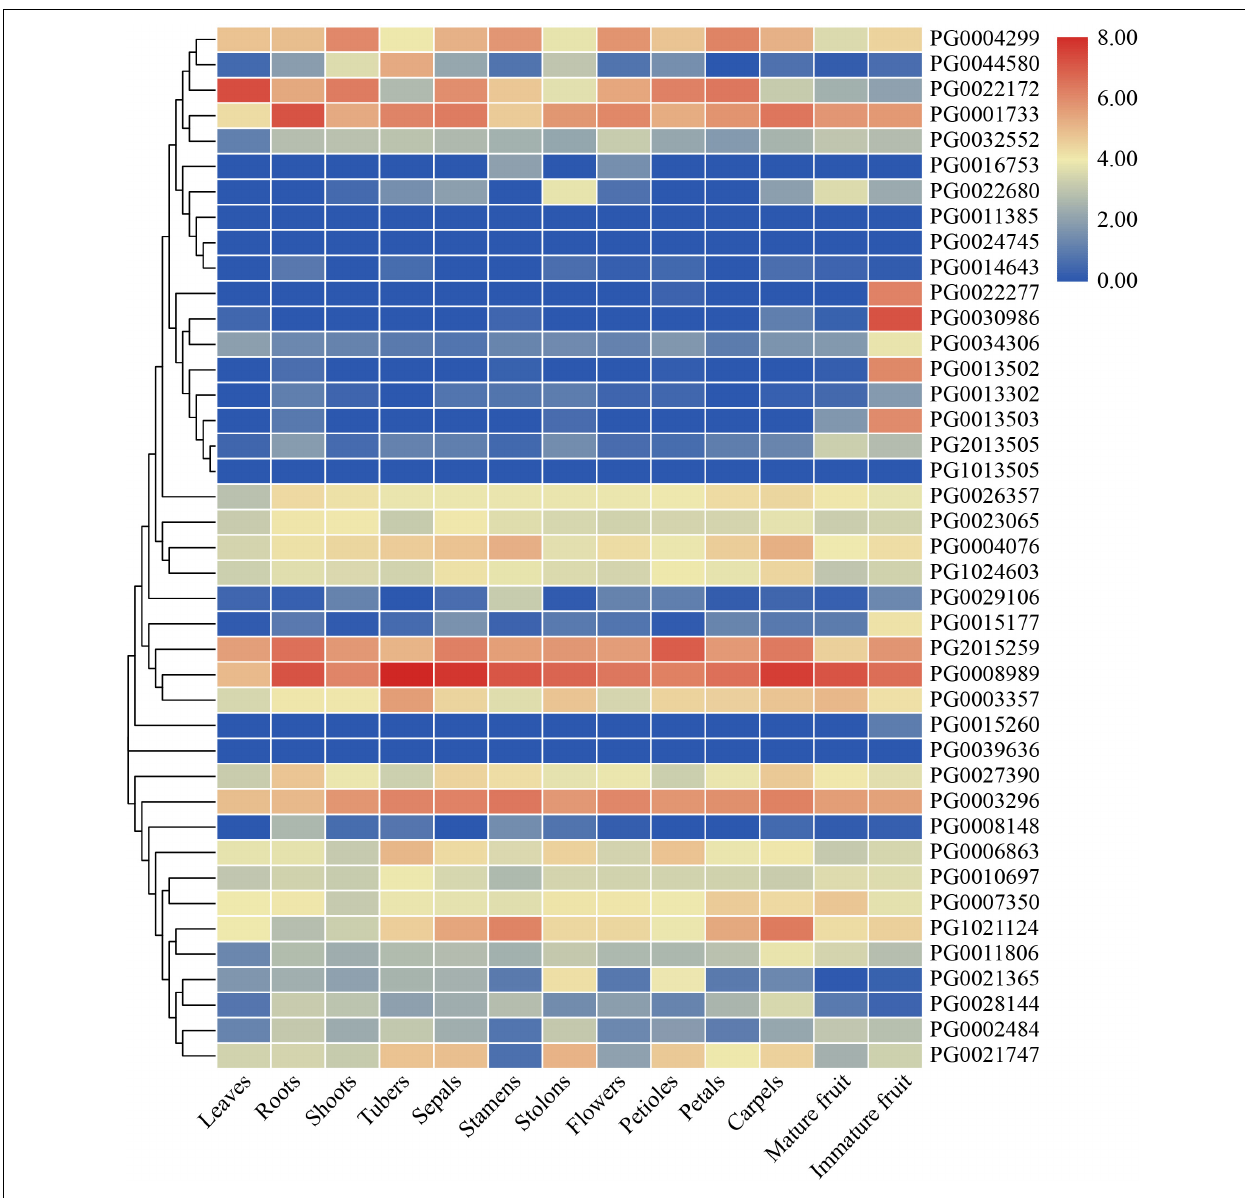
FIGURE 7 | An expression profile analysis of StNF-Y genes in different tissues (leaves, roots, shoots, tubers, sepals, stamens, stolons, mature flowers, petioles, petals, carpels, immature fruit, and mature fruit) in double haploid (DM) potato based on the transcriptome data. The color in the heat map represents the fragments per kilobase of exon per million fragments mapped (FPKM) value using logarithm with a base of